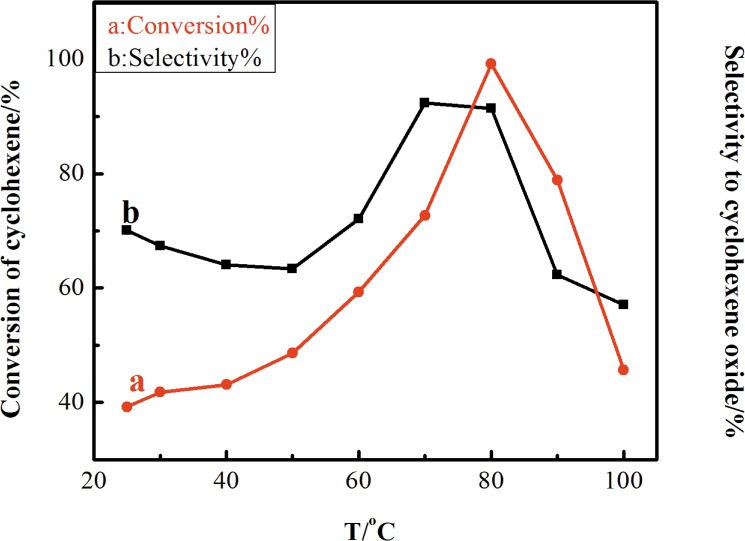
Effect of reaction temperature on the catalytic performance of Ag-TiO2-SiO2 in the epoxidation of cyclohexene.(Reaction conditions: catalyst, 80 mg; cyclohexene, 6 mL; H2O2, 6 mL; chloroform, 12 mL; for 120 min).